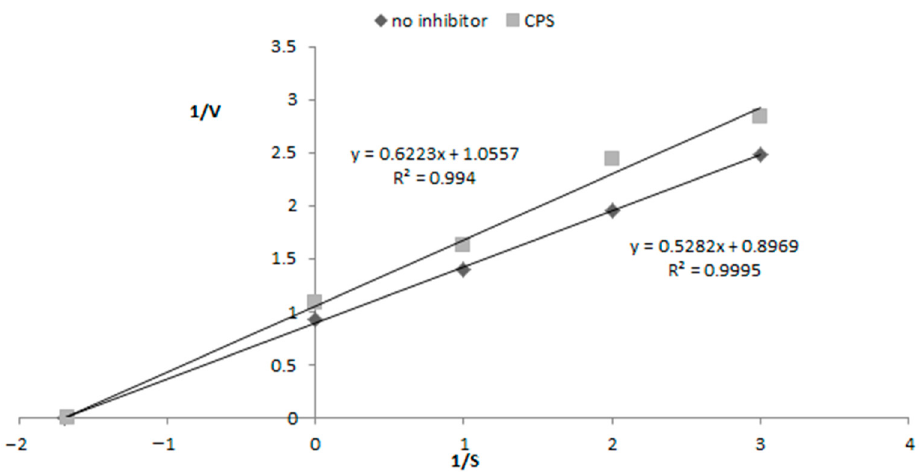
Figure 5. Mode of 15-lipoxygenase (LOX) inhibition by CPS determined by the Lineweaver–Burk plot.